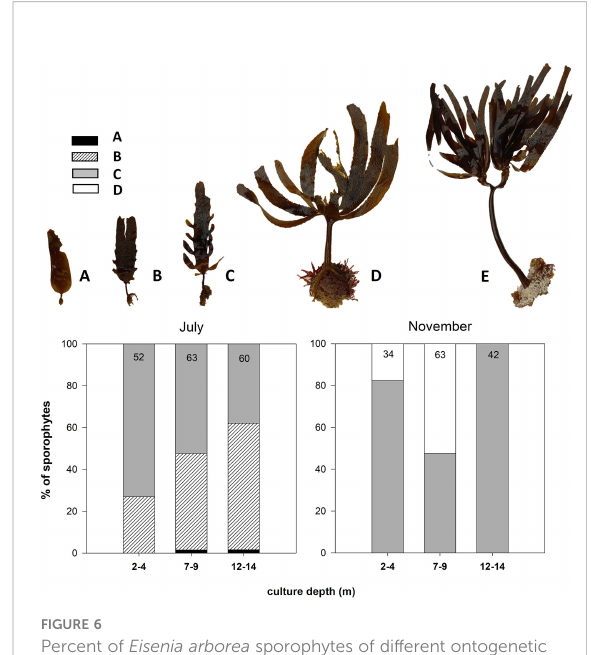
FIGURE 6 Percent of Eisenia arborea sporophytes of different ontogenetic development measured at two sampling times (July and November 2016) and at three different culture depth ranges (2 – 4, 7 – 9, and 12 – 14 m). Numbers inside the bars indicate the number of sporophytes analyzed per depth. Upper pictures have been modi fi ed from Arnold (1980) and show the different ontogenetic stages of E. arborea